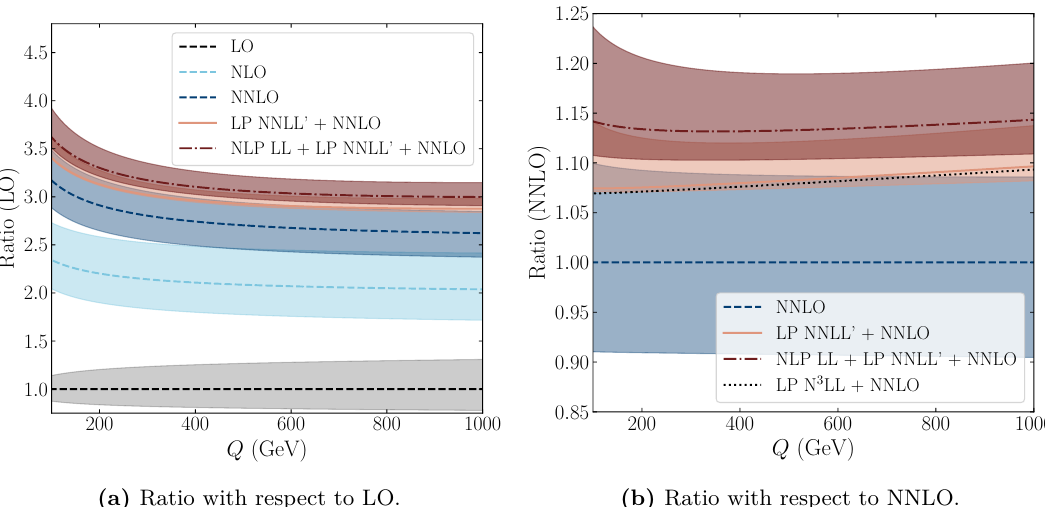
Figure 10. Left: ratio plot for the Higgs total cross section, normalized to the LO result. The fixed-order results at LO, NLO and NNLO are shown in black, light-blue and dark-blue dashed lines respectively. The LP NNLL 0 (+NLP LL) resummed result matched to NNLO is indicated by the orange solid (red dash-dotted) lines. The scale variation, obtained by varying µ between µ = Q/ 2 and µ = 2 Q , is indicated by the coloured bands. Right: ratio for the same distribution normalized to the NNLO distribution. We also show the N 3 LL resummed result, indicated by the black dotted line. The scale-uncertainty band for the N 3 LL distribution is not shown, as it overlaps with the one obtained for the NNLL 0